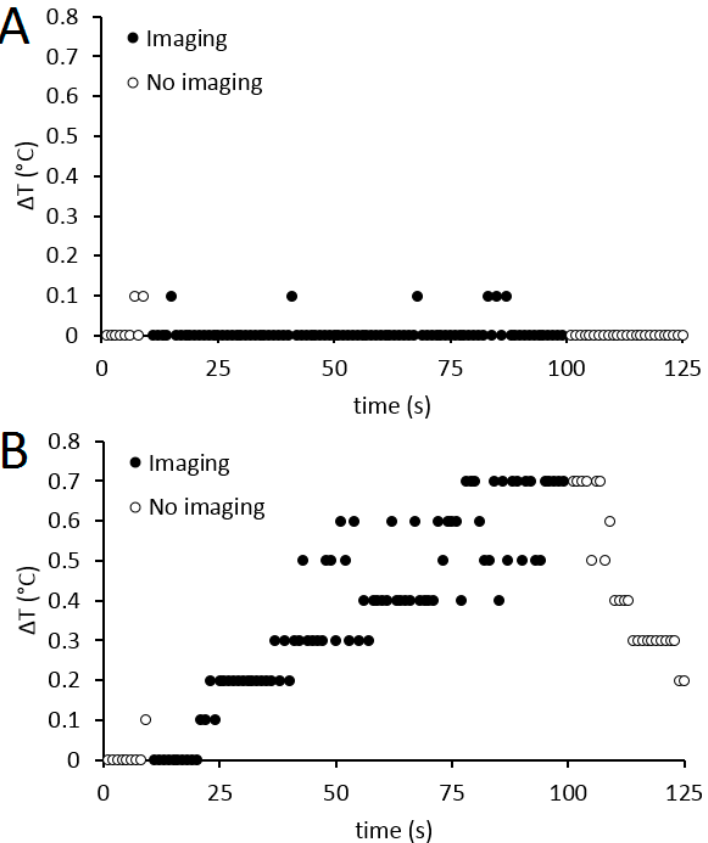
Figure 3. An example of the temperature curves as a result of radiofrequency-induced heating along the shaft of catheter A with microcatheter inserted (during which it was positioned extremely close to the bore). At t = 10, the T1 VIBE sequence ( A ) or the TRUFI RF max sequence ( B ) was initiated and at t = 100, and the sequence was terminated.